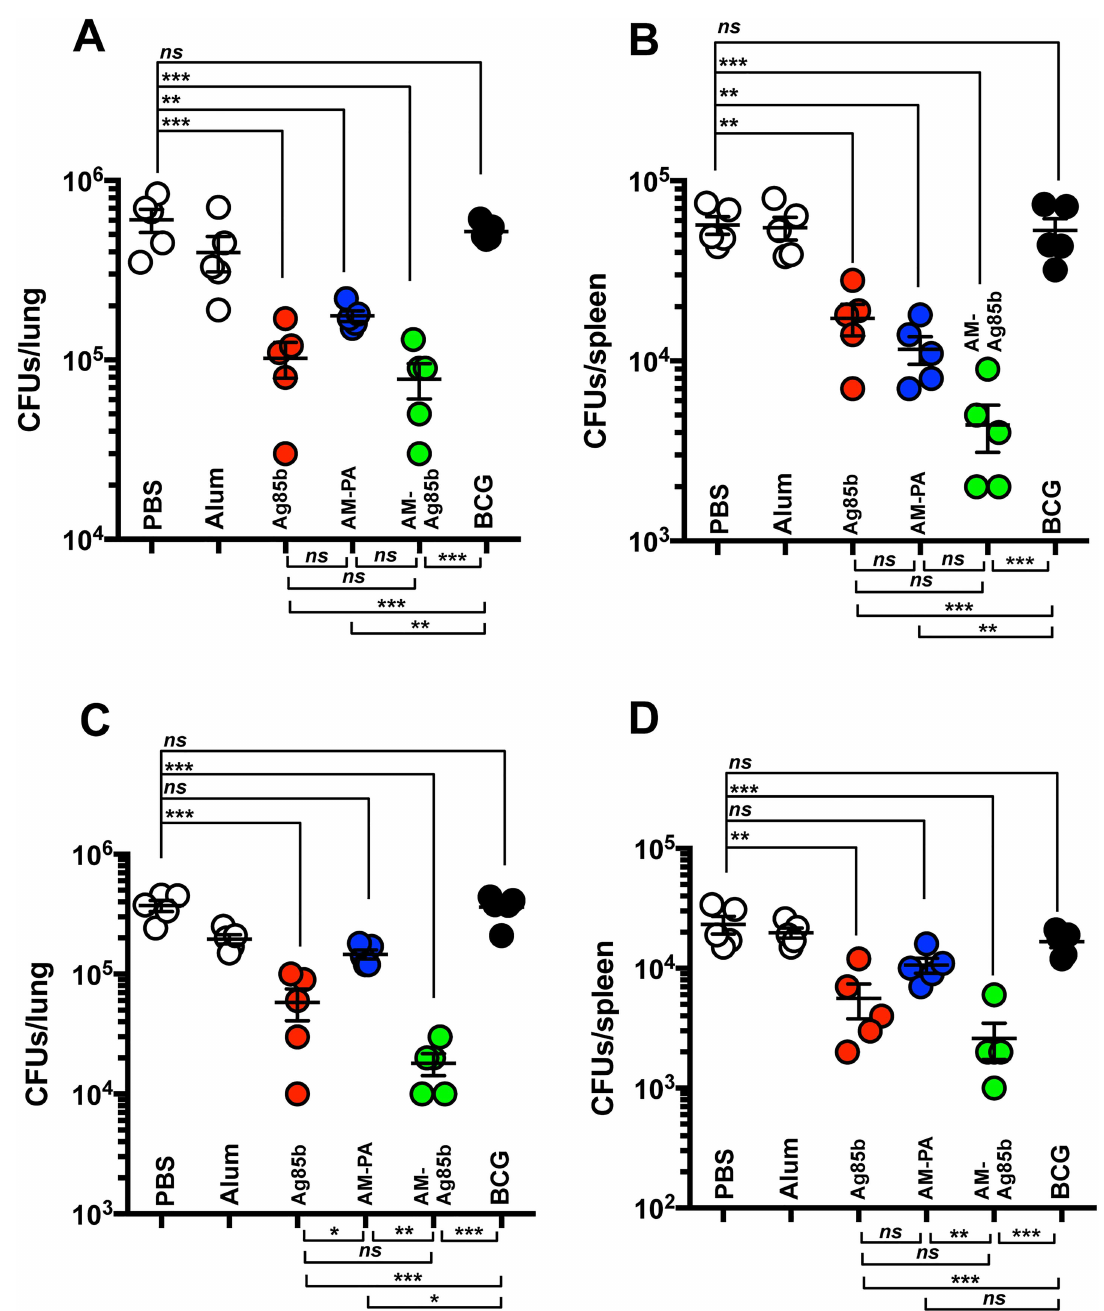
Fig 5. Passive transfer of immune serum and adoptive T cell transfer modify the course of mycobacterial infection. (A,B) Bacterial burden(CFUs) in the lungs (A) and spleen (B) at 4 weeks after infectionwith a low dose of Mtb H37Rv via aerosol (approx. 100 CFUs) of individualna ï veC57BL/6mice that previouslyreceived passively serum preparations. Results are representative of two similar and independent experiments. Experimental groups used 5 mice. ( * P < 0.05, ** P < 0.01,one- way ANOVA with Tukey post-test). (C,D) Bacterial load (CFUs) in the lungs (C) and spleen (D) of individual na ï veC57BL/6 mice adoptively transferred with 4 x 10 6 T cells from the indicatedimmunizedmice were determined at 4 weeks after infection with a low dose of Mtb H37Rv via aerosol (approx. 100 CFUs). The results are representative of two similar and independent experiments. Experimental groupsused 5 mice. ( * P < 0.05, ** P < 0.01,one-wayANOVA with Tukey post-test).